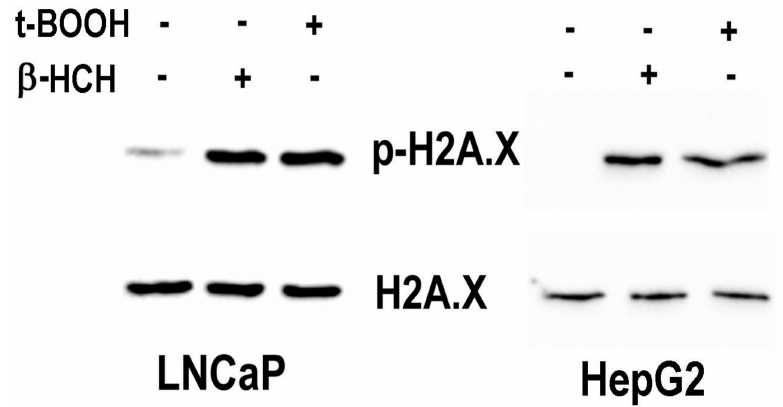
Figure 10. β -HCH induces the phosphorylation of H2AX at Serine 139. Nuclear protein extracts were obtained from both LNCaP and HepG2 exposed to 10 µ M β -HCH for 4 h or 75 µ M t-BOOH for 1 h used as a positive control for DNA damage. The immunoblot shows a comparable increase in the intensity of the band corresponding to phosphorylated H2AX in samples treated with β -HCH as well as t-BOOH in either LNCaP or HepG2 cells. Each sample was normalized against the unmodified H2AX levels present in the same protein extract. The experiment was repeated three times and a representative blot is